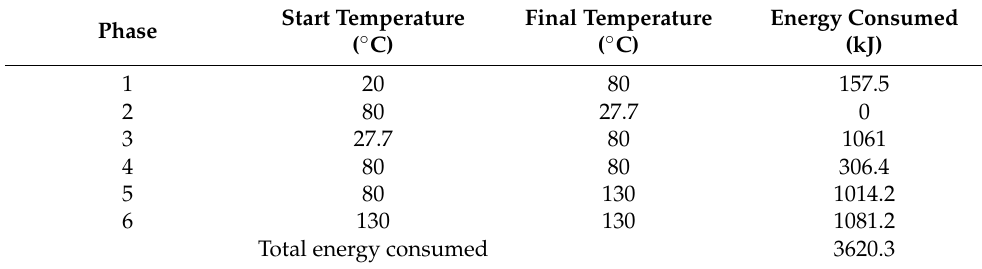
Figure 11. ( a ) Traditional autoclave cure cycle, ( b ) cure cycle for cool-clave processing (redrawn from [29]). Table 1. Estimated energy consumption of a traditional autoclave cure cycle (reproduced from [12,27]).